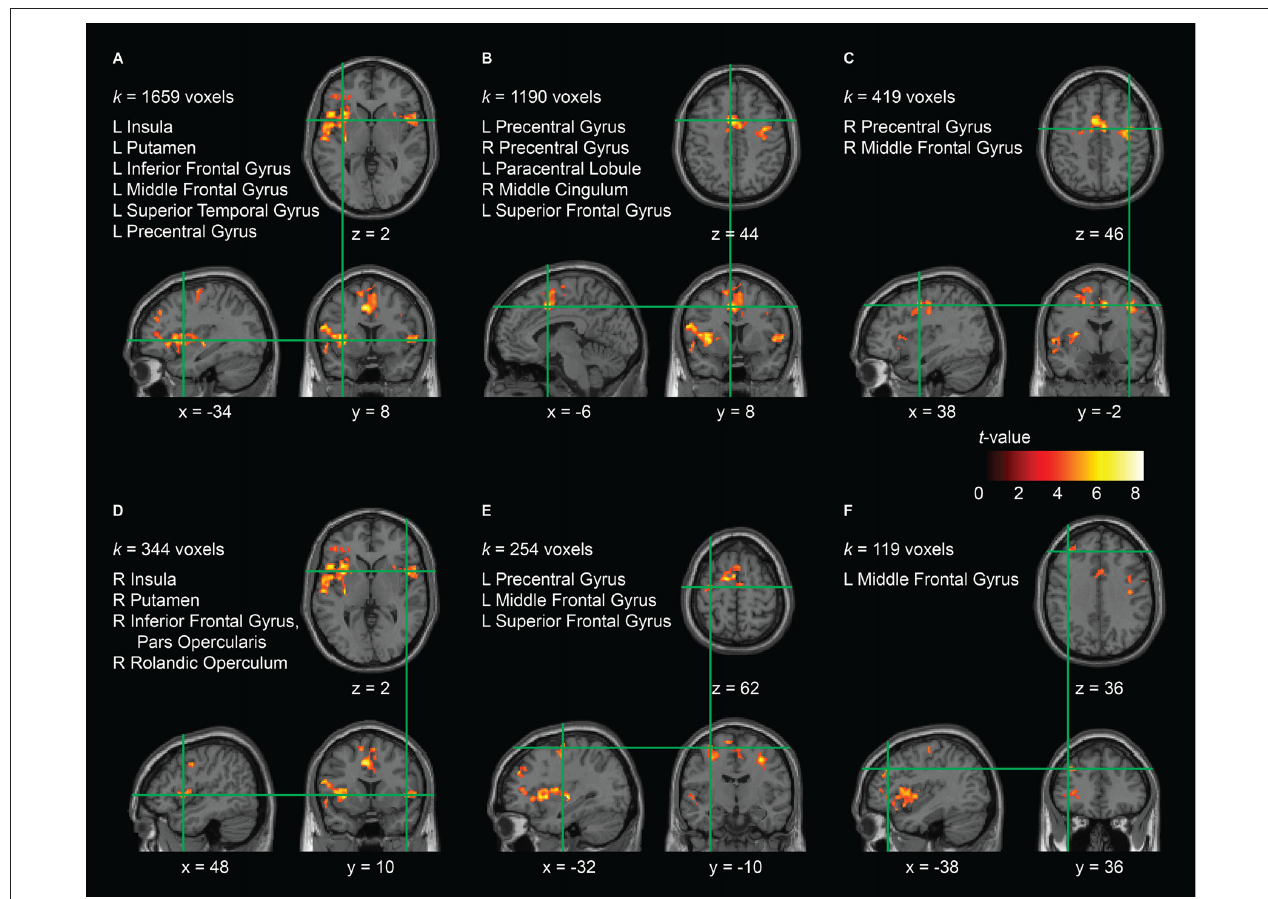
FIGURE 4 | Effect of the balance training on brain activity during AO+MI in the training group. Six clusters (A–F) were identified that were significantly more activated before the training than after it. For each cluster, the anatomical brain structures over which it extends and the cluster size ( k ) are indicated. The copdordinates (numbers and green lines in the images) indicate the position of the local maximum (voxel with the highest t -value) within each cluster. Significant effects were assessed at the cluster level using cluster defining height and extent thresholds of p < 0.001 (uncorrected at the voxel level) and k = 100 contiguous voxels at an FWE rate of p < 0.05 (corrected at the cluster level), respectively. Contrasts are presented on a normalized single-subject brain in the MNI space.